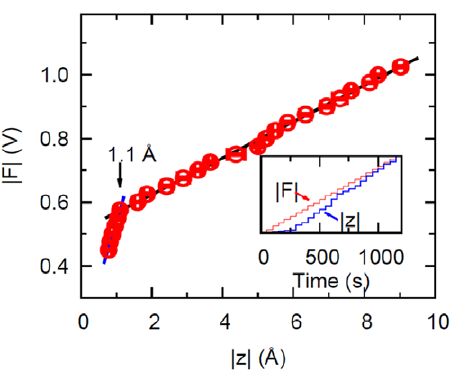
Figure 3. Dynamic force-extension curve. Force vs deformation measured at 10 Hz for the protein Guanylate Kinase, exhibiting a yield deformation of 1.1 A˚. The force is in arbitrary units (corresponding to the voltage applied to the chamber), the deformation in A˚. The error bars represent the standard deviation of 5 measurements. Inset: Stepwise increase of the applied force and the corresponding averaged amplitude of the protein’s deformation in real time.